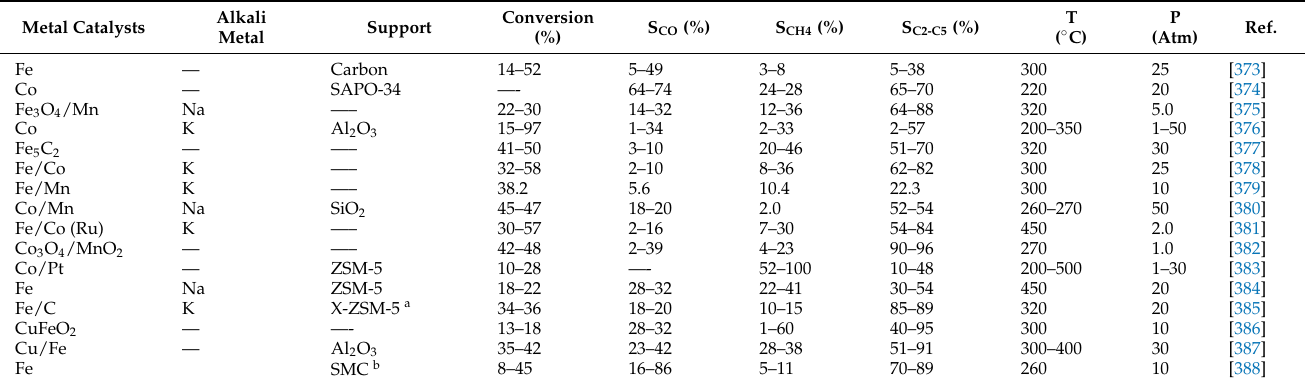
Table 11. Comparative summary of different catalytic systems for FTS process activity improving the direct conversion of CO 2 to light